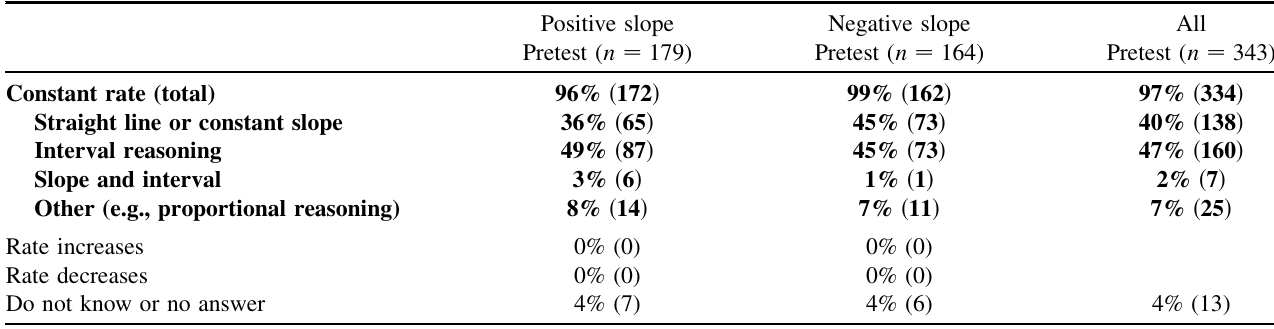
TABLE V. Pretest results for the question whether the water level is changing at an increasing, decreasing, or constant rate. No significant difference was found between positively and negatively sloped